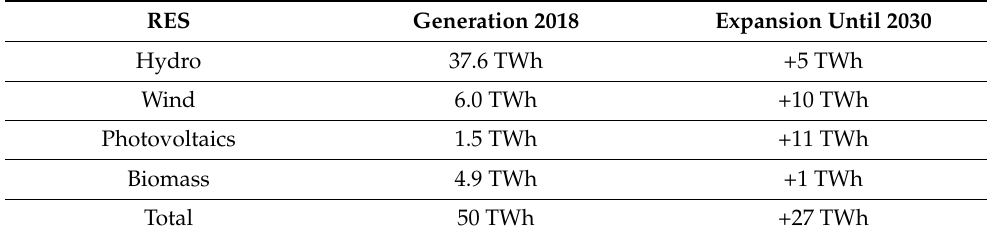
Table 3. Expansion of RES until 2030 [4,107].